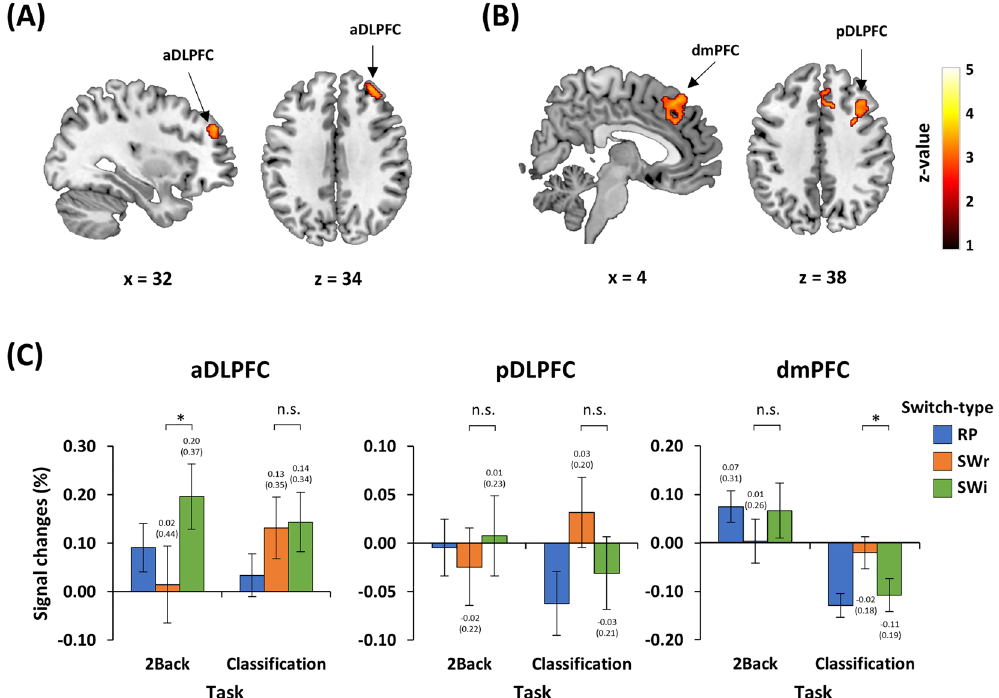
Figure 3. Significant brain activations associated with the retrieval of weak representations (RWR) via 2 × 2 interaction [(2Back-SWi–2Back-SWr) > (Classification-SWi–Classification-SWr)] and pairwise comparisons of the signal change in the identified clusters. ( A ) Activation of the right anterior dorsolateral prefrontal cortex (aDLPFC) was uniquely associated with RWR interaction following exclusive masking of the simple updating and switching. ( B ) Activation of the posterior dorsolateral prefrontal cortex (pDLPFC) and dorsomedial prefrontal cortex (dmPFC) mainly overlapped with regions activated by simple updating. ( C ) The bar graph represents the signal changes of the aDLPFC, pDLPFC, and dmPFC for each experimental condition. The post-hoc pairwise comparisons were tested using paired simples t-tests based on significant interactions. Error bars indicate the standard error of the means. The statistical threshold maps were shown at p < 0.05 cluster-level correction for multiple comparisons with the cluster size defined at a voxel level, uncorrected p < 0.001. Color bars represent the t-values. RP repeat, SWr switch-relevant, SWi switch-irrelevant. The activated clusters are overlapped onto the ch2better.nii template using mricron software (version 09.02.2019, https:// www. nitrc. org/ proje cts/ mricr on) 71